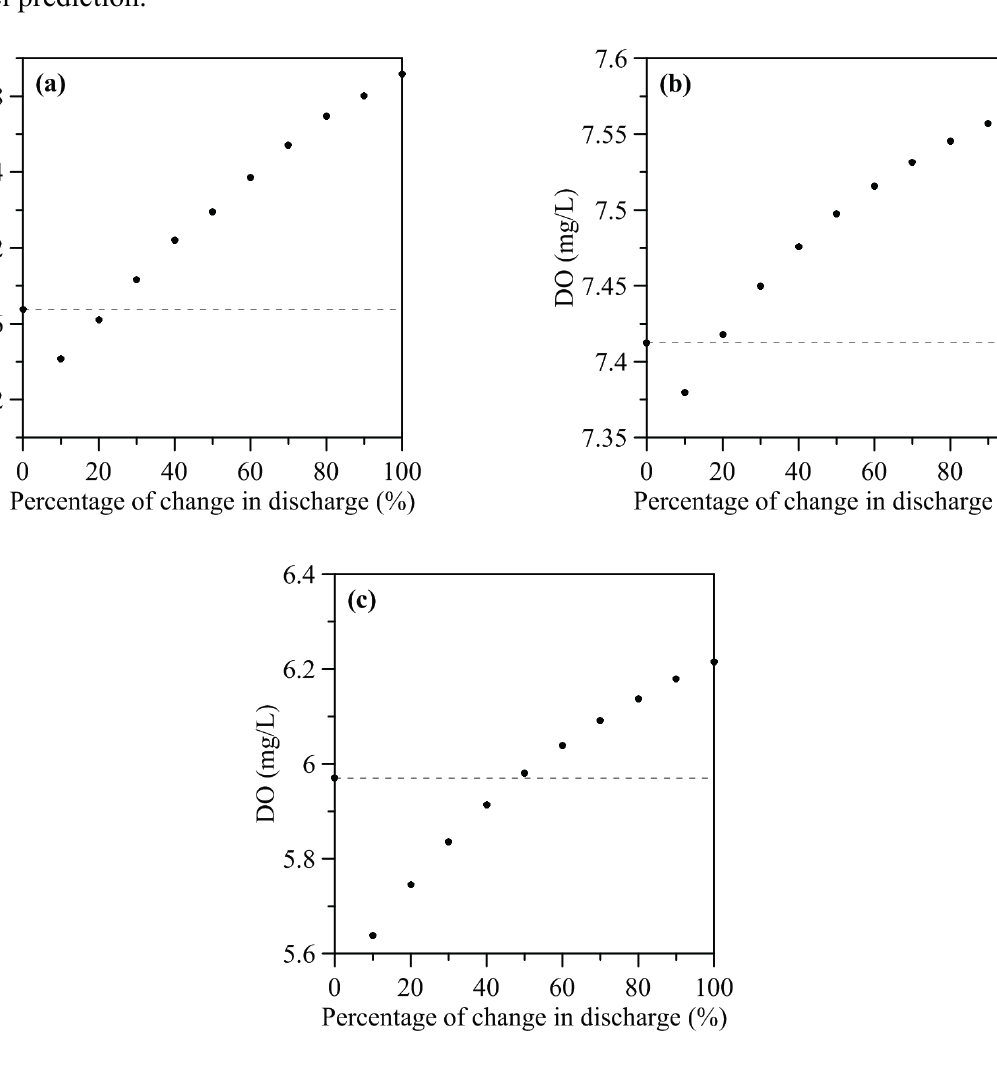
Figure 10. Predicting dissolved oxygen concentration for Scenario 2 at different locations: ( a ) Hsin-Hai Bridge; ( b ) Chung-Cheng Bridge; and ( c ) Nan-Hu Bridge. Note that the incremental ratio of the Q flow is 10% for each run. The black point represents the 75 model